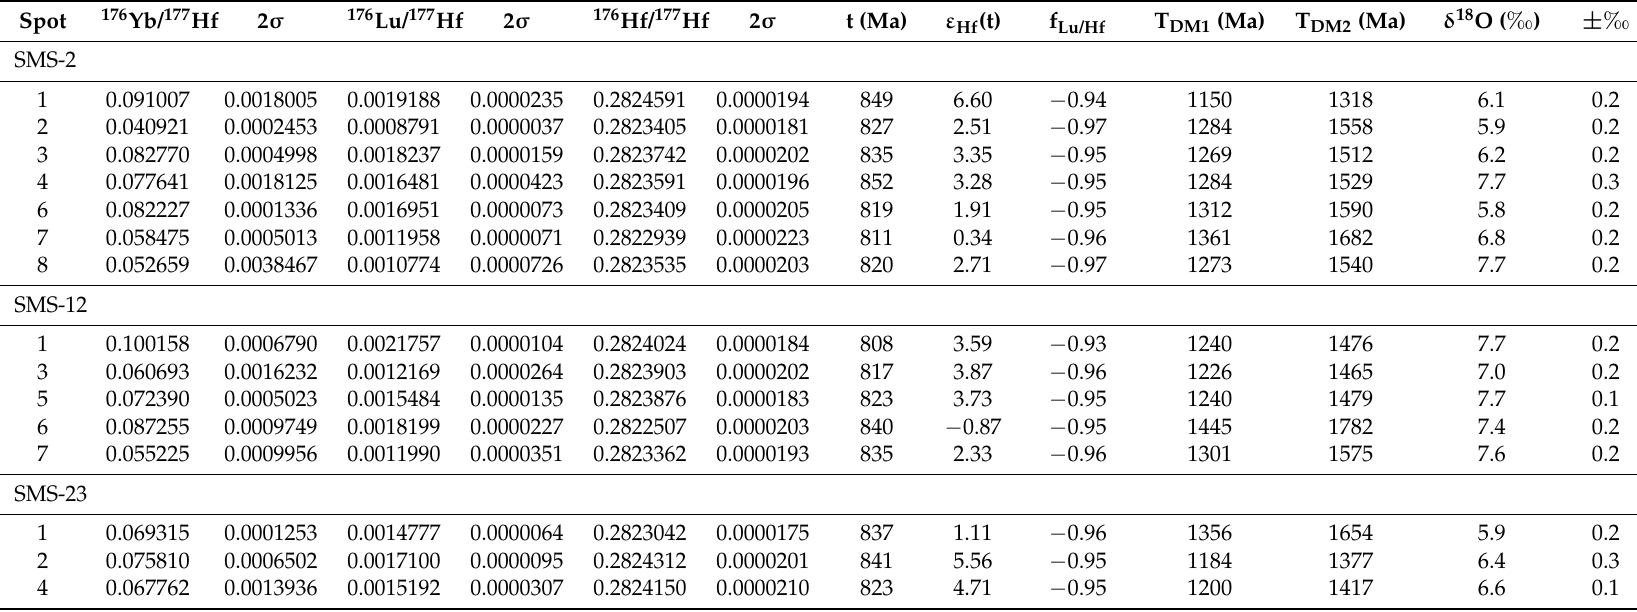
Table 4. Zircon Hf–O isotope data of the Shimensi